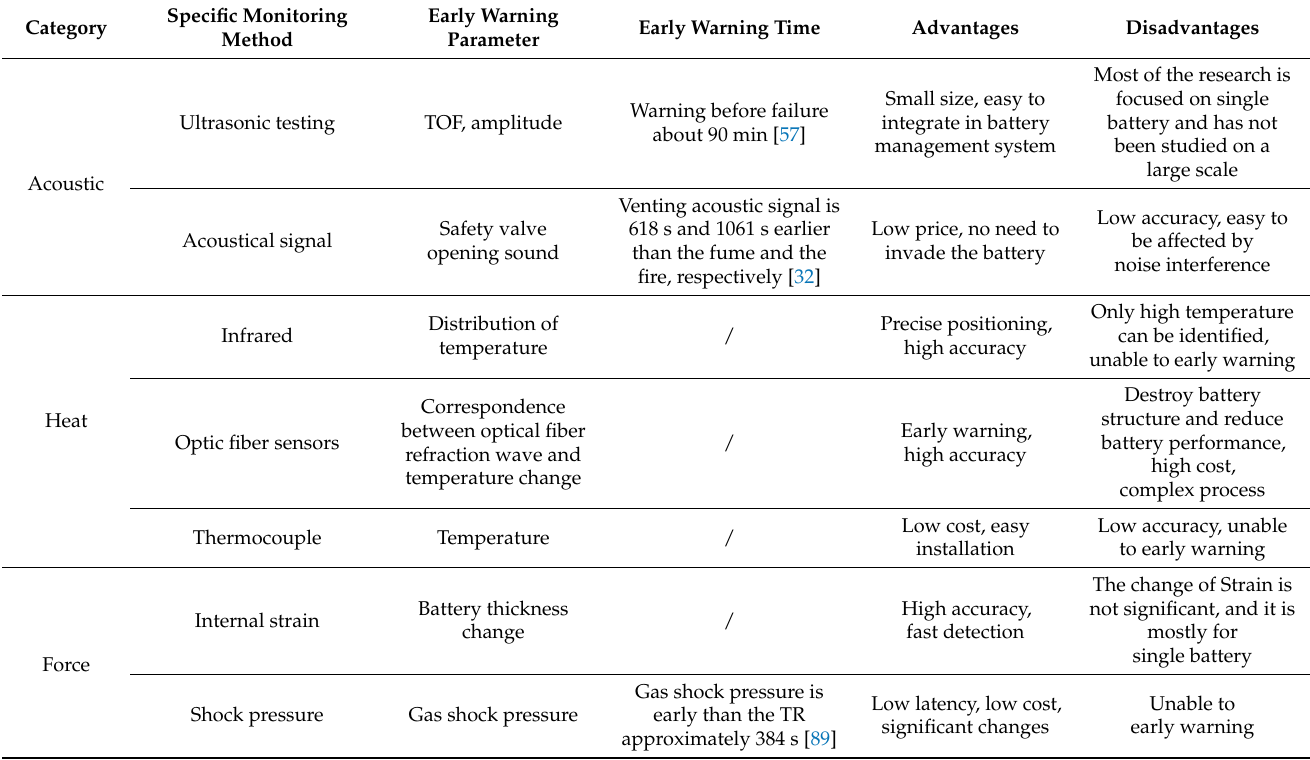
Table 3. Typical monitoring and warning methods for TR and their advantages and